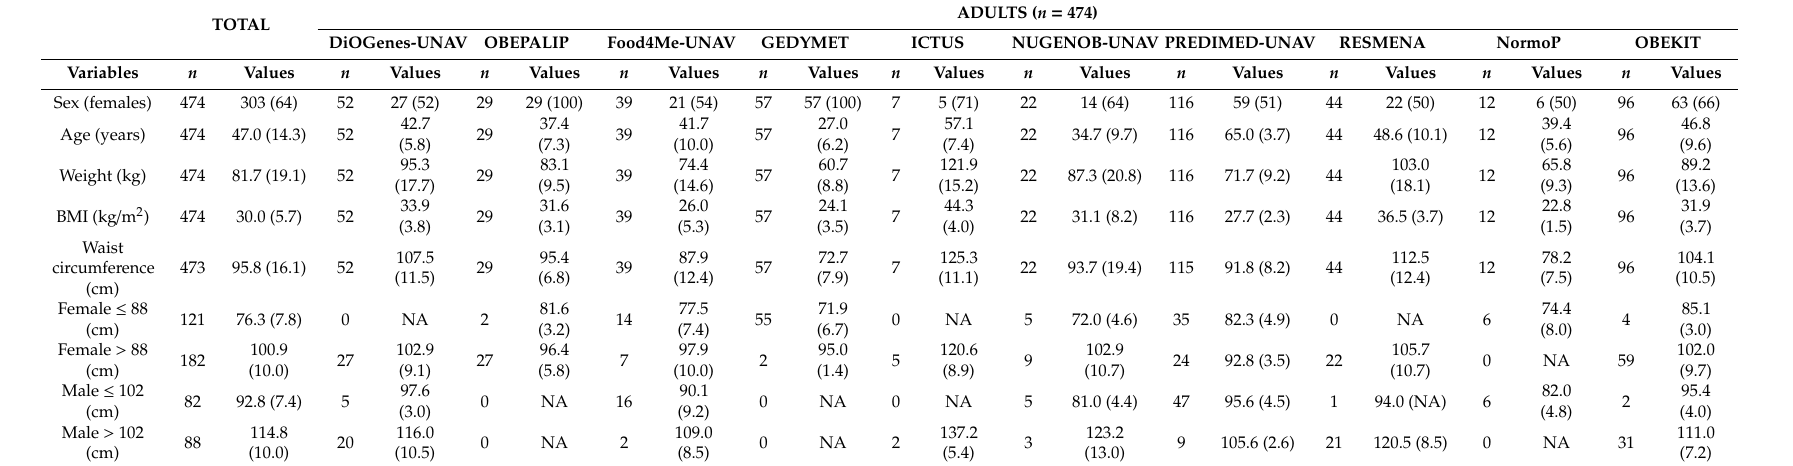
Table 1. Anthropometric, clinical, and biochemical characteristics of the study population categorized by project /